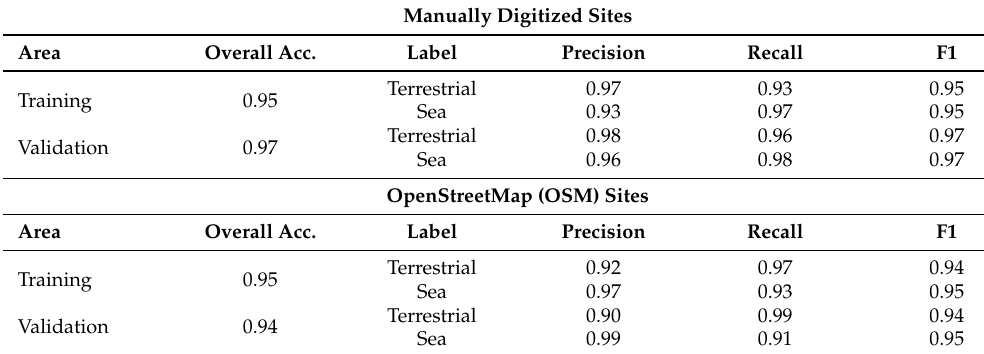
Table 2. Accuracy statistics within a 500 m buffer around the manually digitized reference coastline (Manual) and OpenStreetMap (OSM) coastline for the final combined binary classification map after post-processing. Precision, Recall, and F 1 -scores are given for both classes, terrestrial area (including inland lakes and rivers) and sea. Accuracy measures are rounded to the second decimal